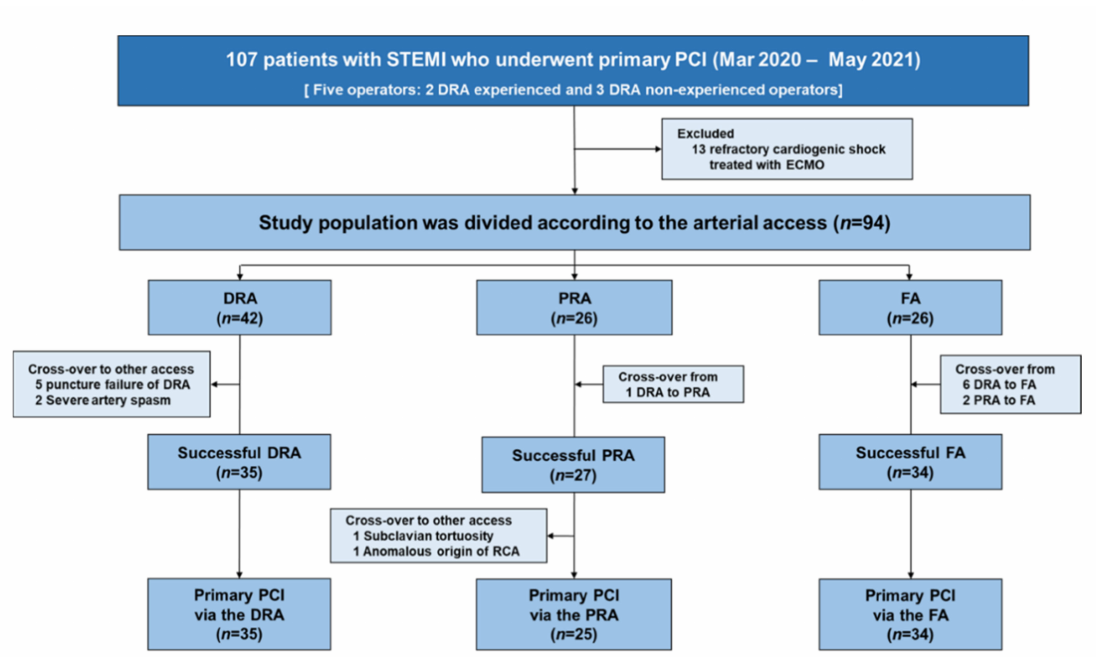
Figure 1. Study flowchart. Abbreviations: ECMO, extracorporeal membrane oxygenation; DRA, distal radial access; FA, femoral access; PCI, percutaneous coronary intervention; PRA, proximal radial access; RCA, right coronary artery; STEMI, ST-elevation myocardial